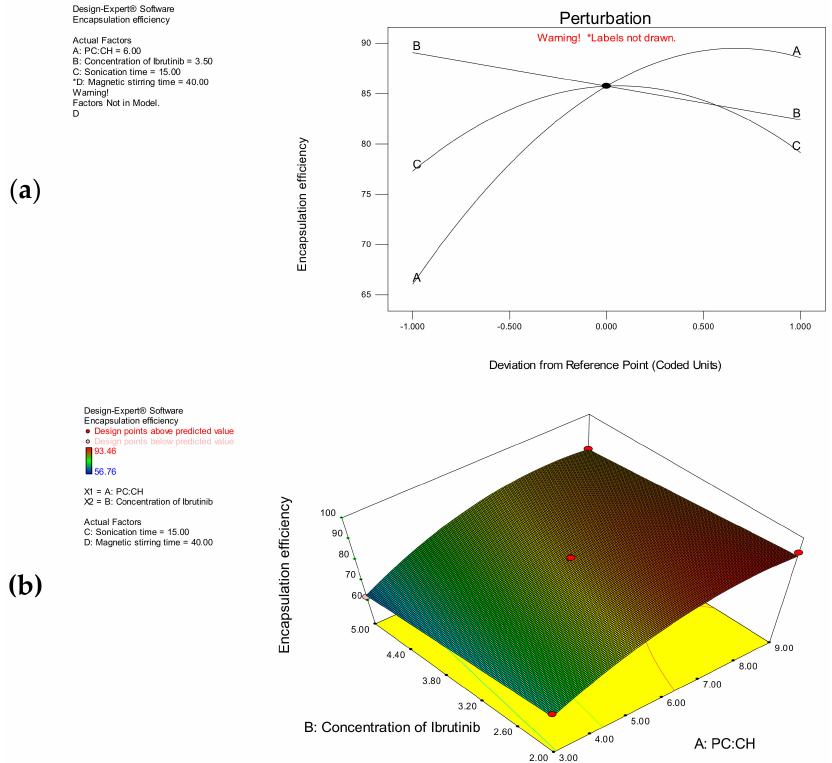
Figure 2. ( a ) Two – dimensional perturbation plot showing the effect of A, B, and C on the encap- sulation efficiency; ( b ) 3D response surface plot showing the interactive effect of A and B on the encapsulation efficiency at constant level of C and D. (* – indicates the Factor D have not shown any significant influence on encapsulation